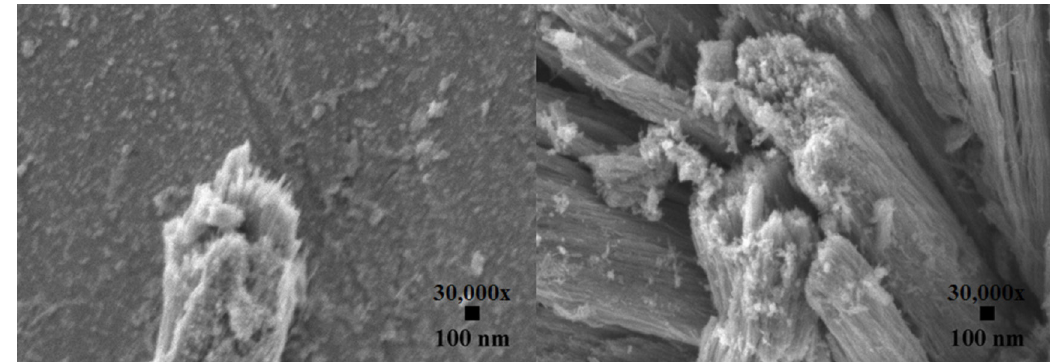
Figure 4. Nanostructures over the surface of anodized titanium with HCl at 15V with a concentration of 0.15M in a) 10 min and b) 30 min of anodization.